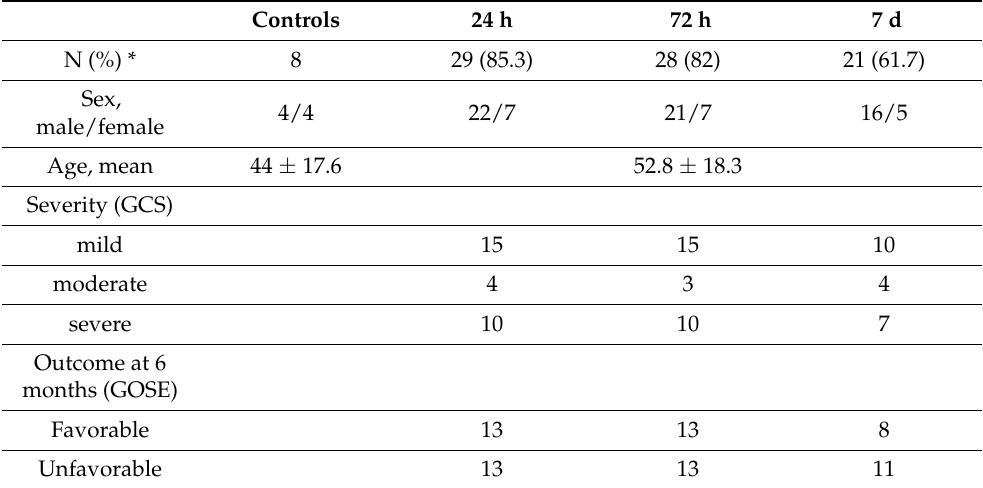
Table 1. Demographic details of the patient